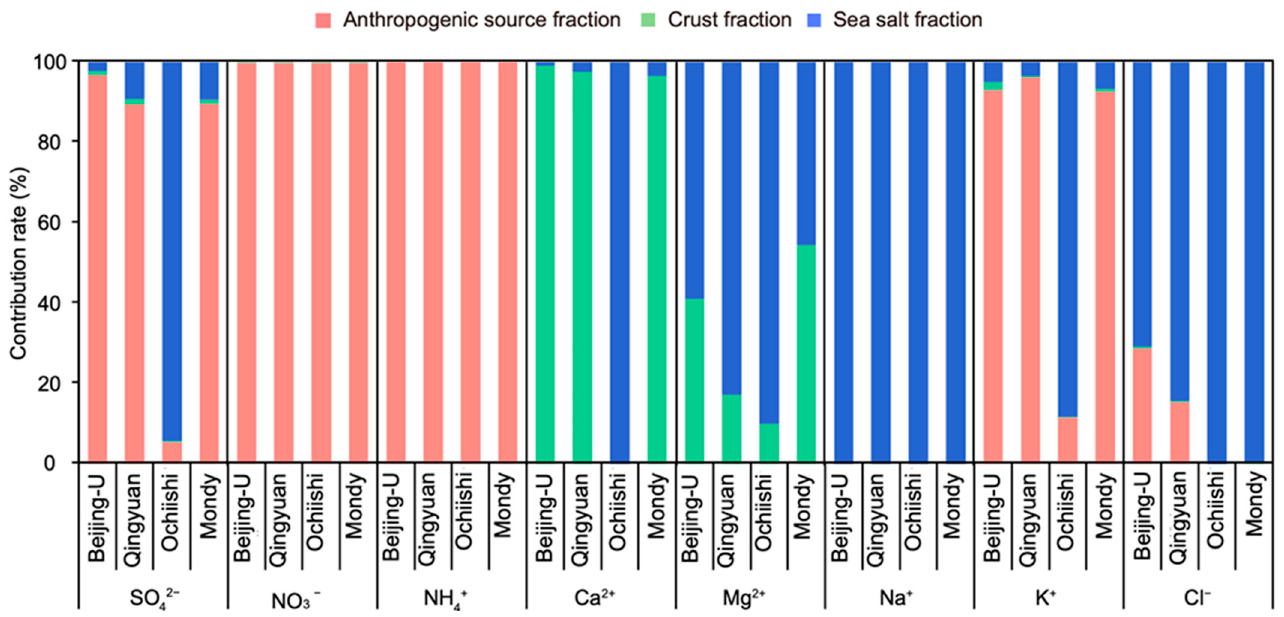
Figure 5. Contribution of each source to the major ions in precipitation into the Qingyuan forest throughout 2018–2020, compared to other representative sites at comparable latitudes.